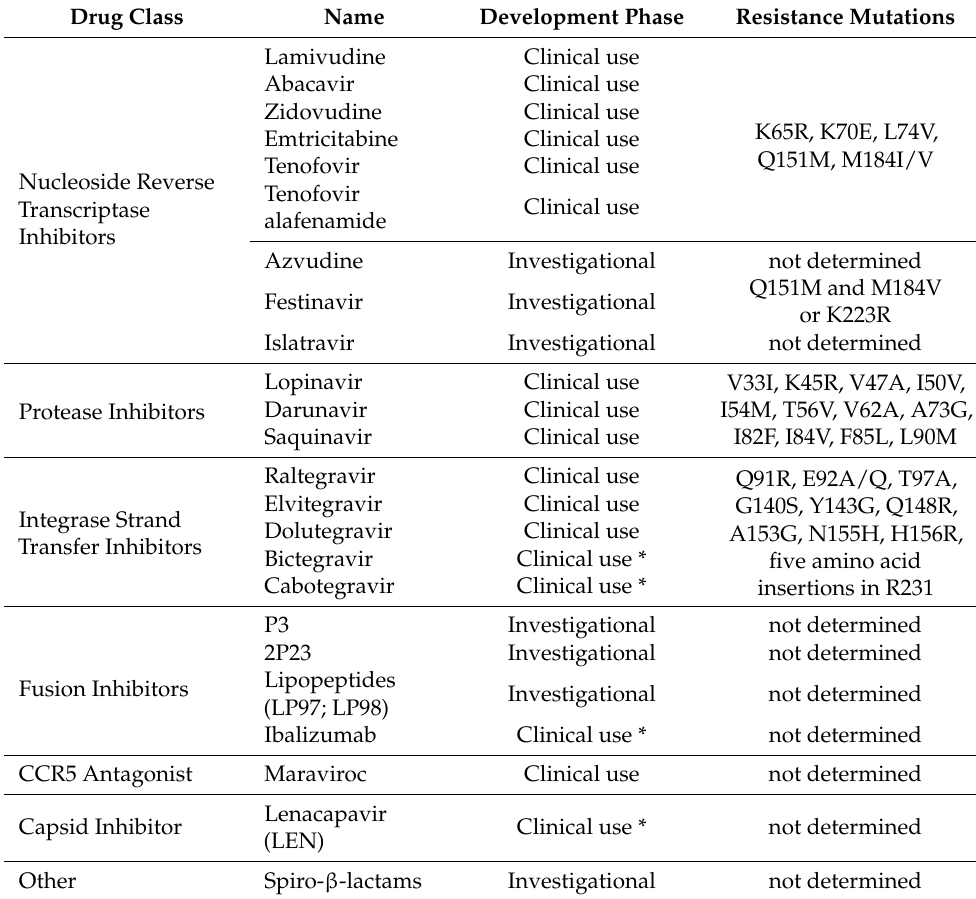
Table 1. Antiretroviral drugs active against HIV-2 and key mutations causing resistance to drugs in clinical